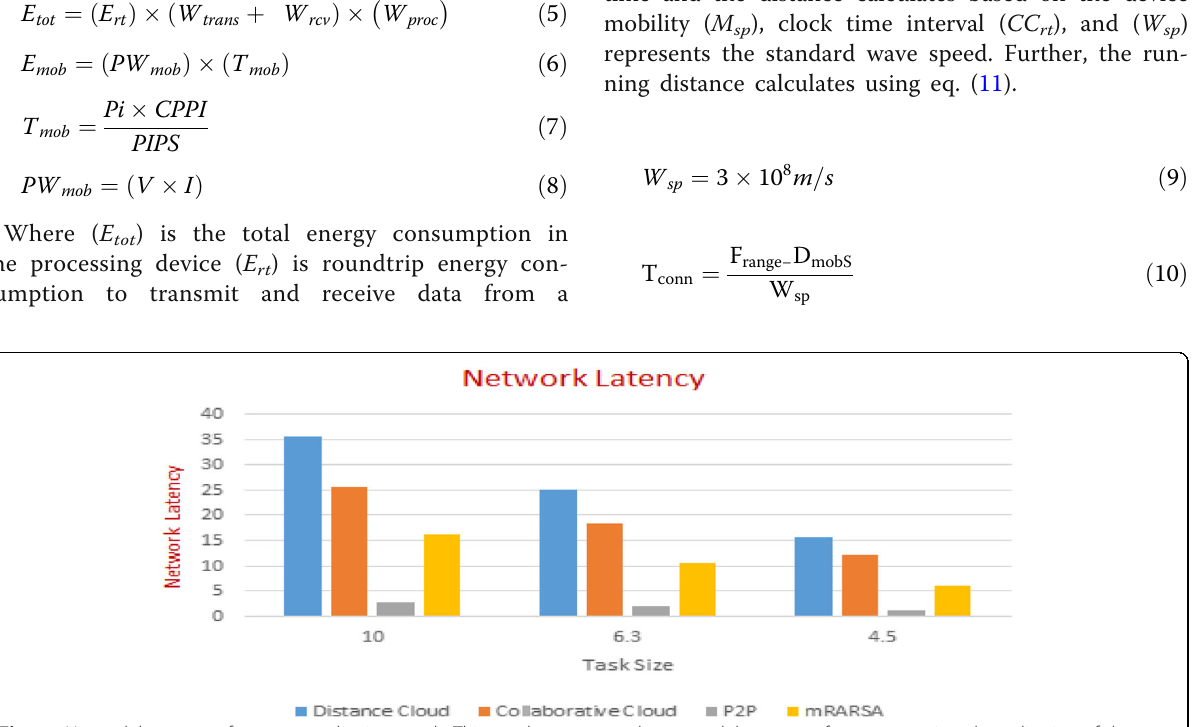
Fig. 11 Network latency performance evaluation graph. This graph represents the network latency performance against the utilization of the running cloud resources for second resource demanding Eight-Queen problem